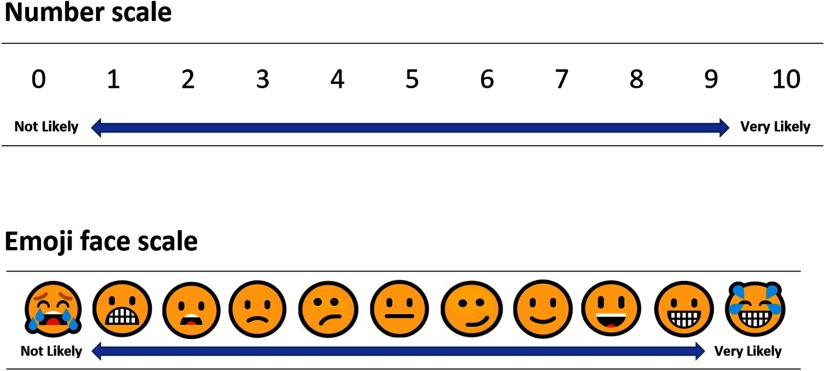
Two Types of Net Promoter Score Rating Scales Tested in India